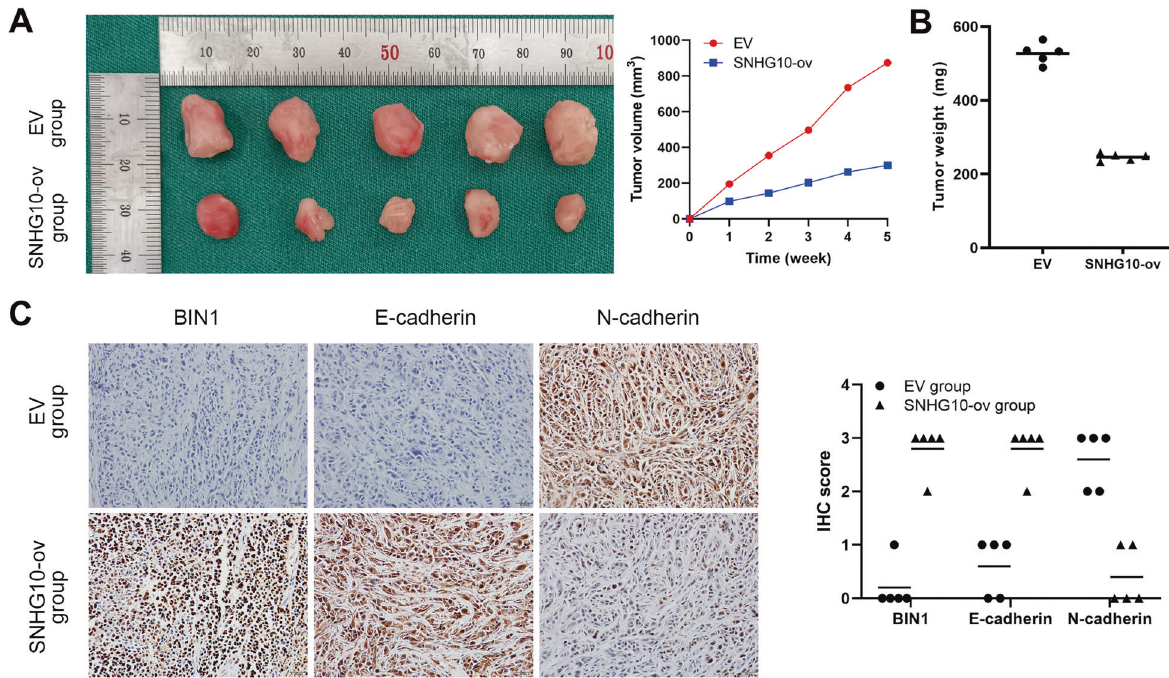
Fig. 8 The effects of SNHG10 on EOC cells in vivo. A SNHG10 overexpression signi fi cantly decreased the tumor volume of tumor-bearing mouse model ( N = 5). Plots indicate mean. B SNHG10 overexpression signi fi cantly decreased the tumor weight of tumor-bearing mouse model ( N = 5). C Difference in the expression of BIN1, E-cadherin and N-cadherin in EOC tissue of xenograft mouse model between EV group and SNHG10-ovexpression group, detected by IHC ( N =